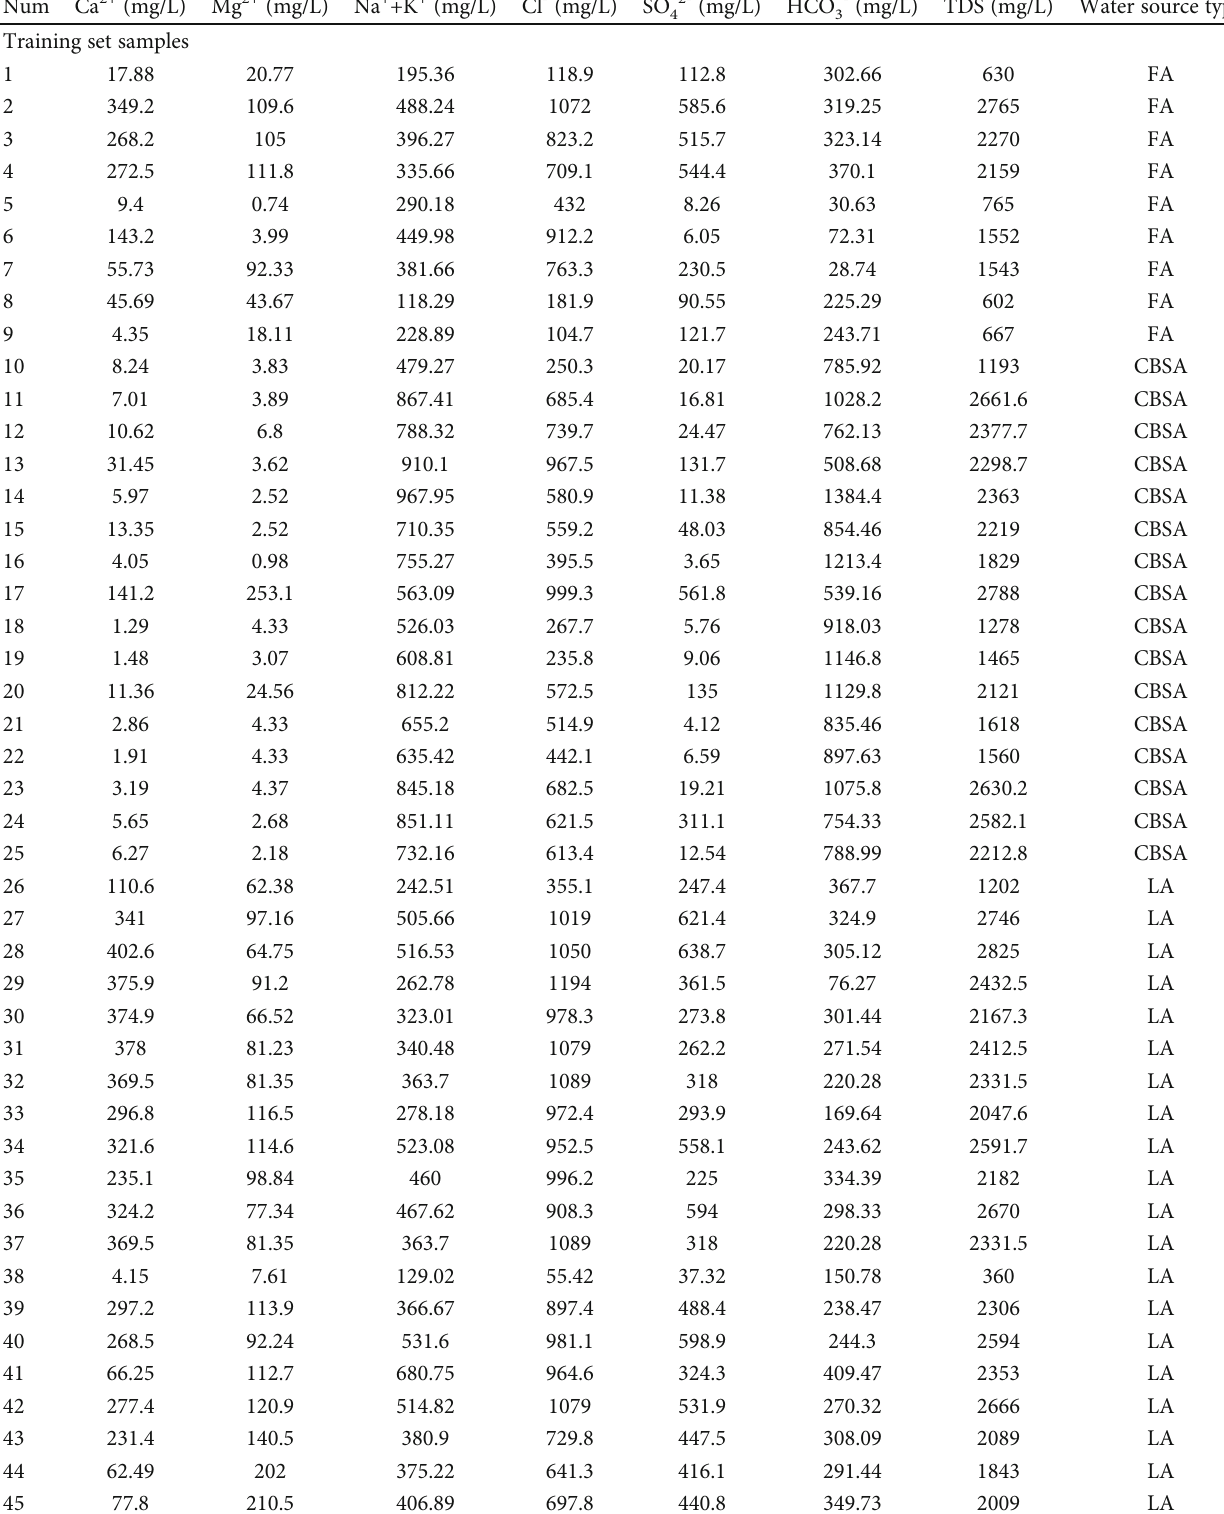
Table 1: Test data for water